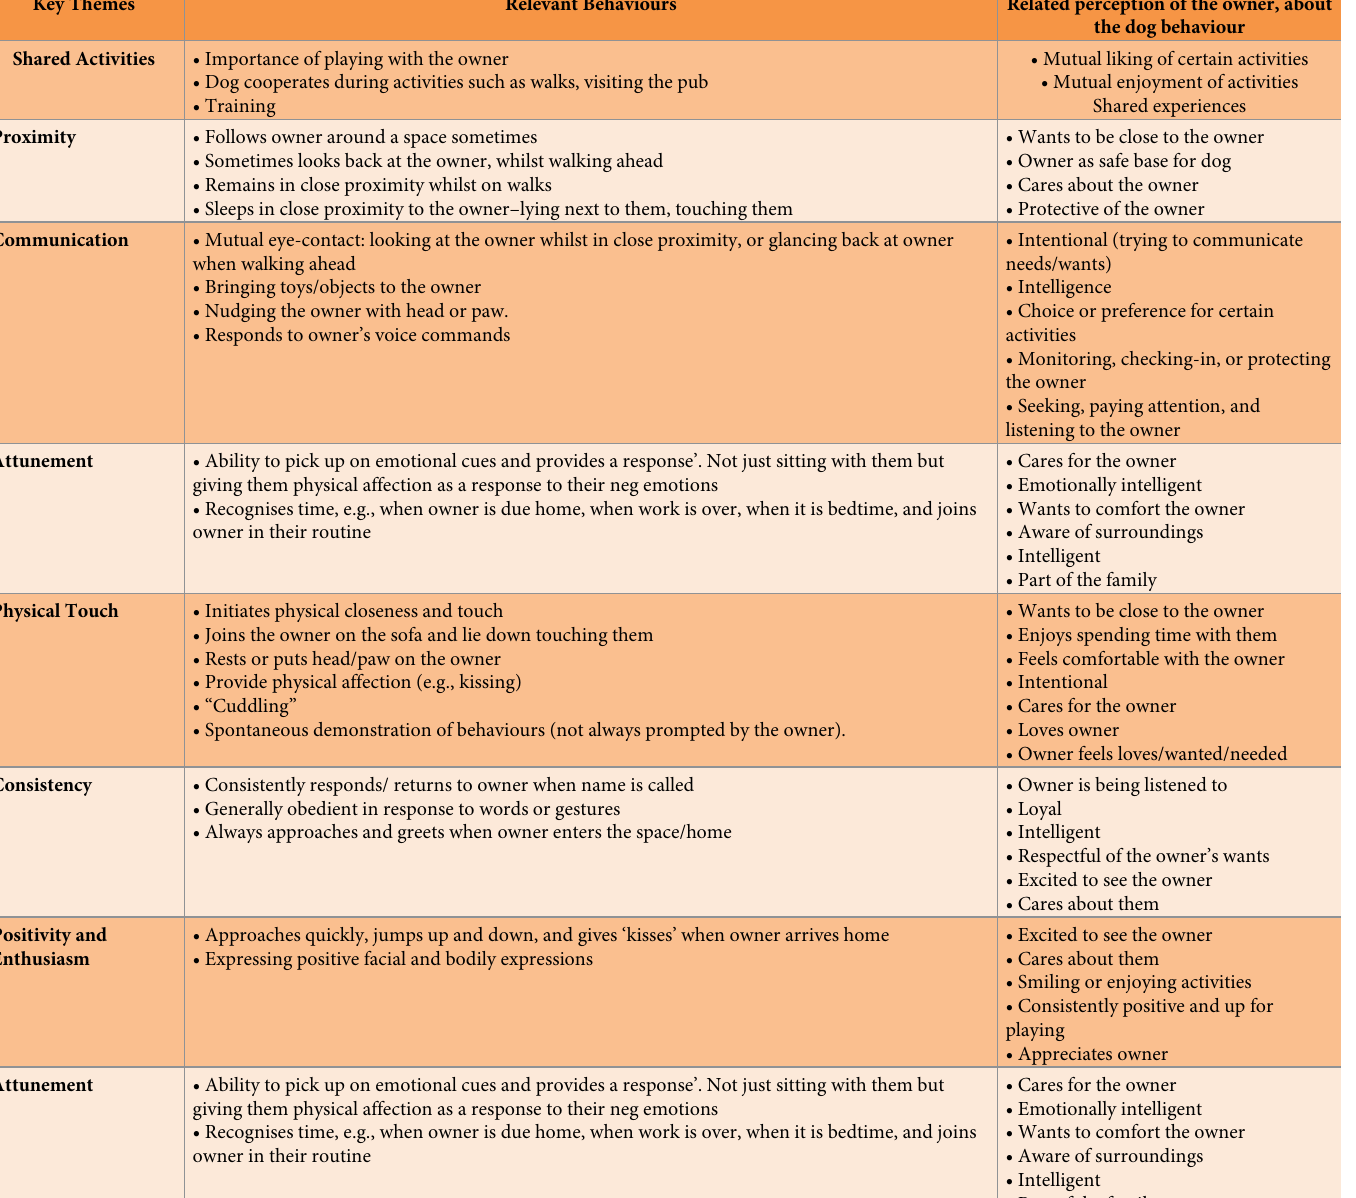
Table 1. Overview of key themes identified in the study, and related perceptions of dog behaviours. Key